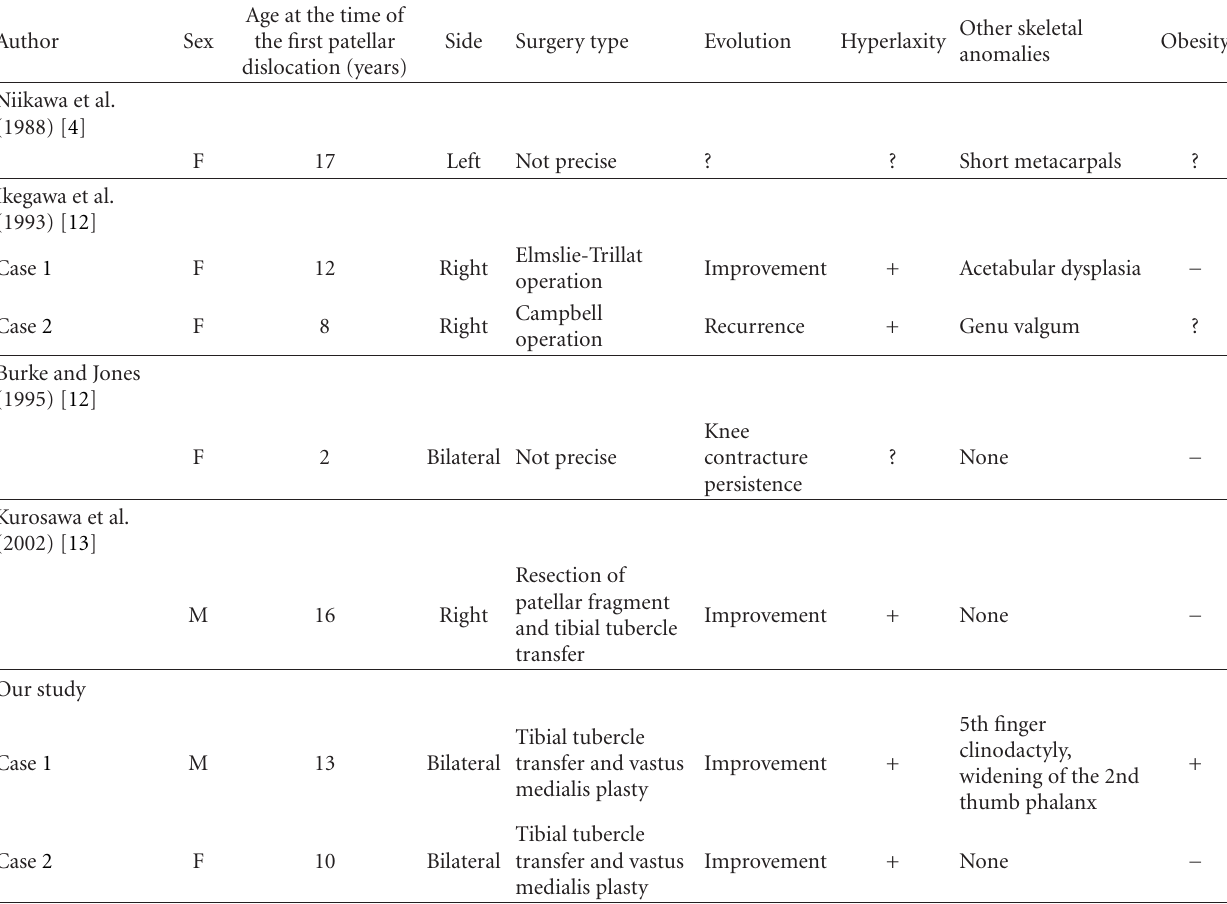
Table 1: Summary of the reported KMS cases with surgically treated patellar